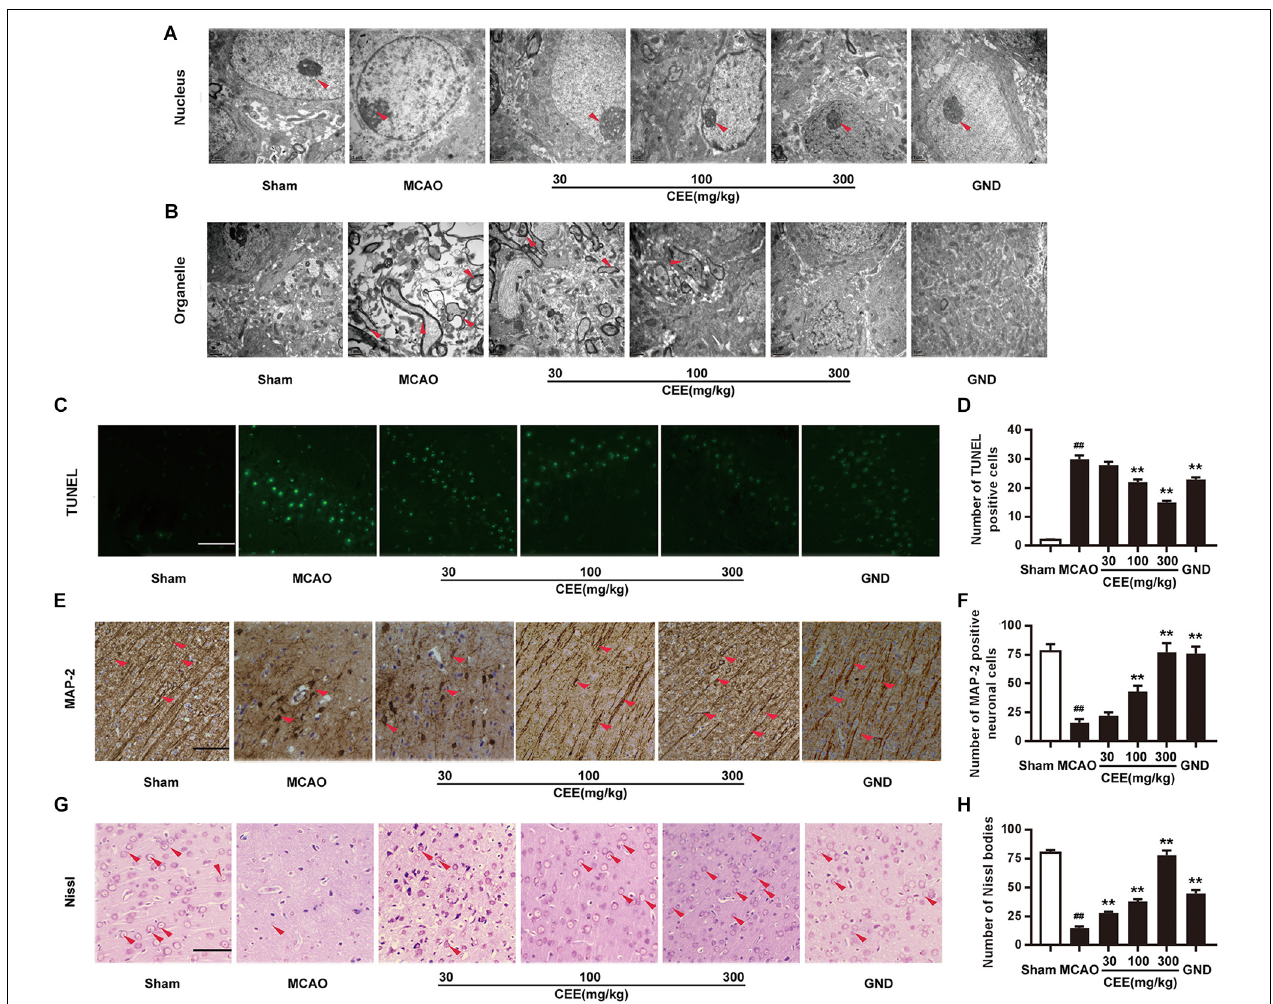
FIGURE 2 | Caesalpinia sappan ethanolic extract inhibits neuronal apoptosis in MCAO rats. (A) Ultrastructural changes in the neuronal cell nuclei in brains as detected by TEM (scale bar: 3 µ m). (B) Ultrastructural changes of the neuronal cell organelles, including the endoplasmic reticulum and mitochondria, in brains as detected by TEM (scale bar: 3 µ m). (C) Neuronal apoptosis as detected by TUNEL staining assay (scale bar: 50 µ m). (D) Quantitative assessment of TUNEL positive cells in rat brain cortex penumbra per field. (E) MAP-2 expression as detected by IHC assay using a specific antibody for MAP-2 (scale bar: 50 µ m). (F) Quantitative assessment of MAP-2 positive neuronal cells in rat brain cortex penumbra per field. (G) Morphologic changes of neuronal synapses as detected by Nissl staining assay (scale bar: 50 µ m). (H) Quantitative assessment of Nissl bodies in rat brain cortex penumbra per field. Six rats in each group and three slices for each rat were examined for TEM analysis. Three rats in each group and three slices for each rat were examined for TUNEL, Nissl staining and IHC assay. Data are expressed as mean ± SD . ## P < 0.01 vs. sham group, ∗∗ P < 0.01, ∗ P < 0.05 vs. MCAO group.